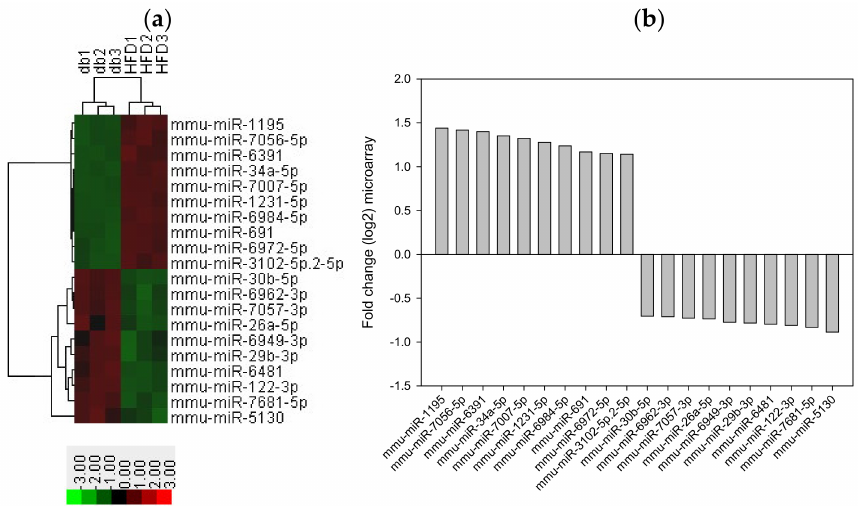
Figure 7. Top 10 upregulated and downregulated miRNA expression in the liver tissue from HFD-fed db/db mice. ( a ) A subset of differential genes was selected for clustering analysis. ( b ) Representation of top 10 upregulated and downregulated genes in red and green colors. miRNAs were detected both by microarray analysis between HFD-fed db/db mice and standard diet-fed db/db mice. The corresponding log2 fold changes in miRNA abundance for each miRNA expression level as determined by microarray analysis are